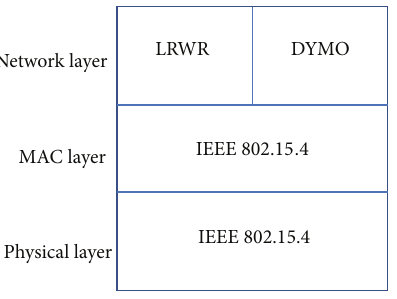
Figure 3: Protocol stack.